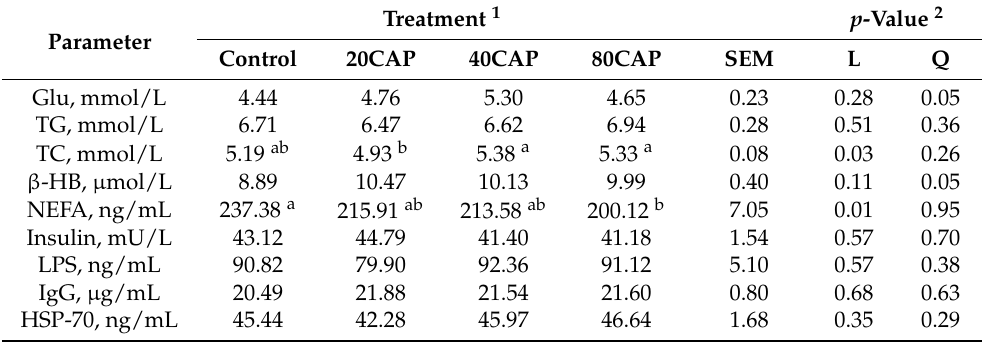
Table 4. Effects of Capsicum oleoresin (CAP) on blood metabolites in heat-stressed dairy cows.